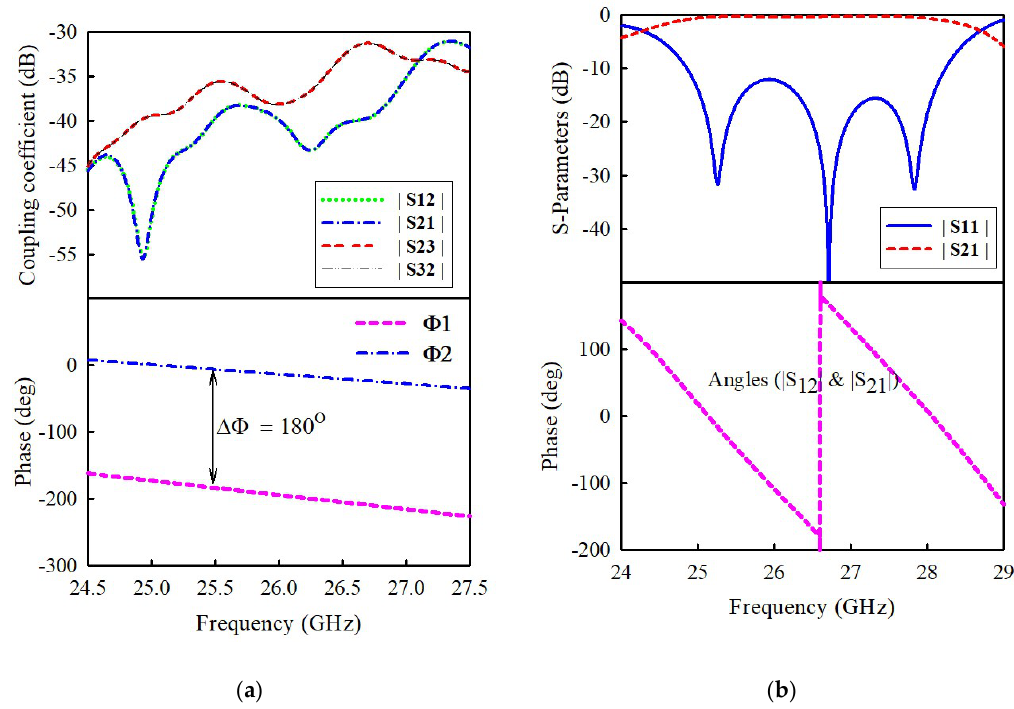
Figure 8. (a) Coupling coefficient and phase of feed network. ( b ) Simulated S11, S21, and phase of waveguide-to-stripline transition.